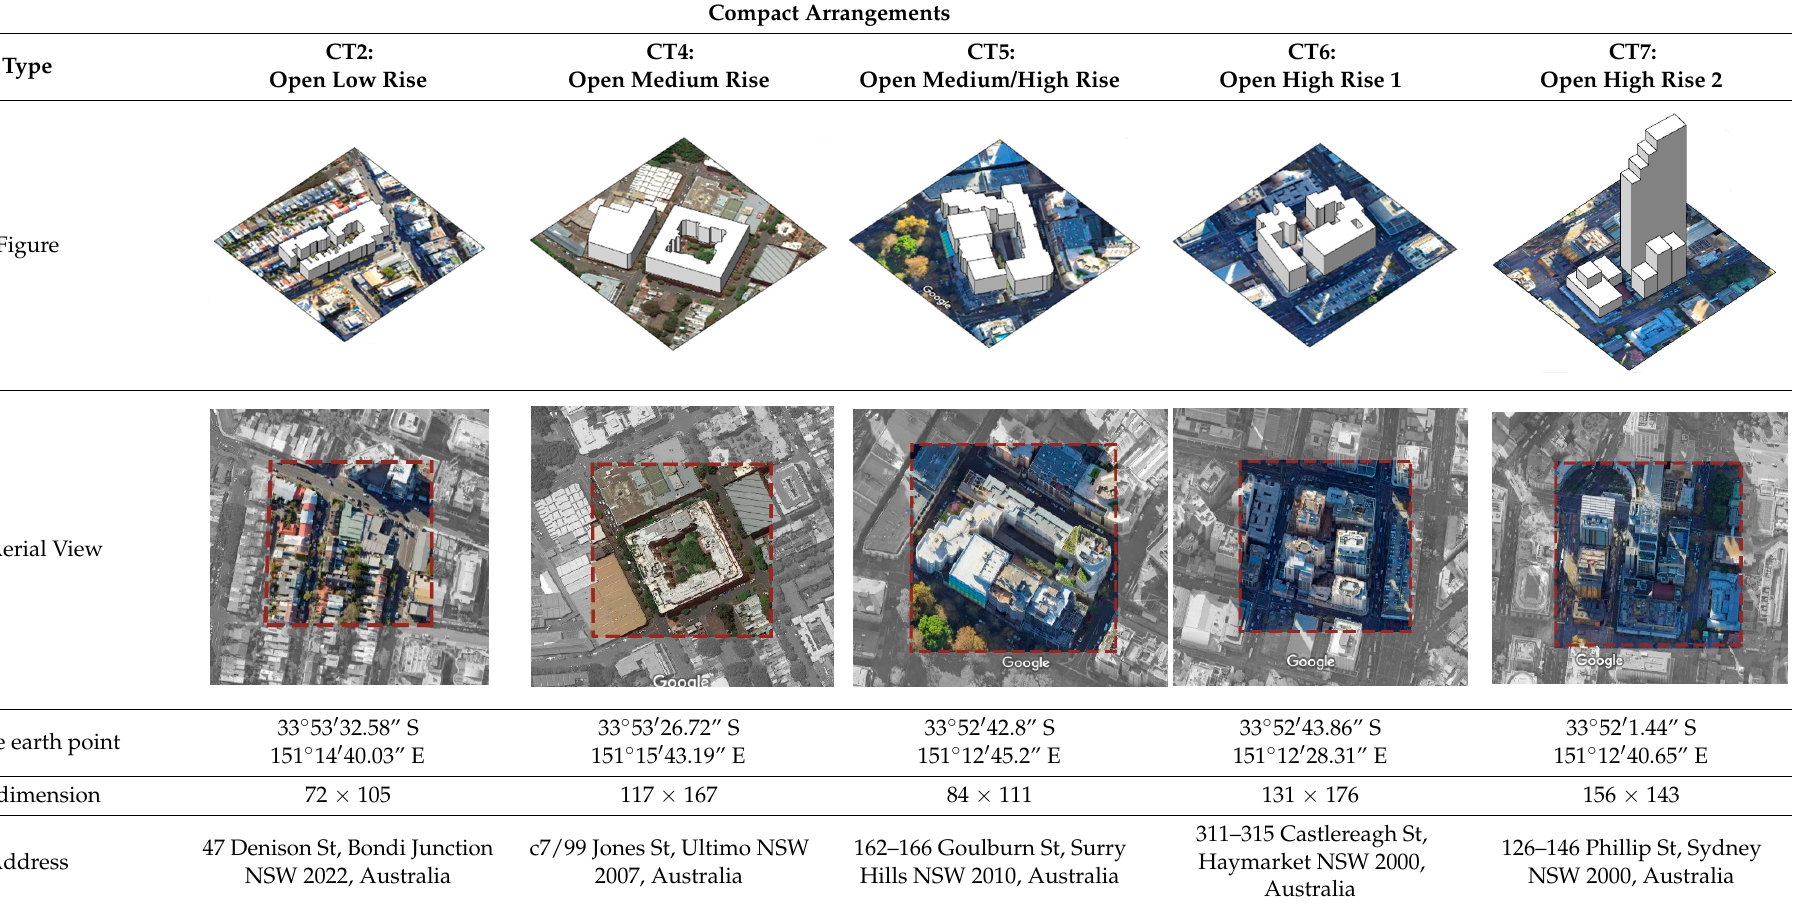
Table 4. Compact Arrangement classifications in urban configurations with their corresponding 2D, and 3D views, site dimensions, and locations in the city of Sydney.